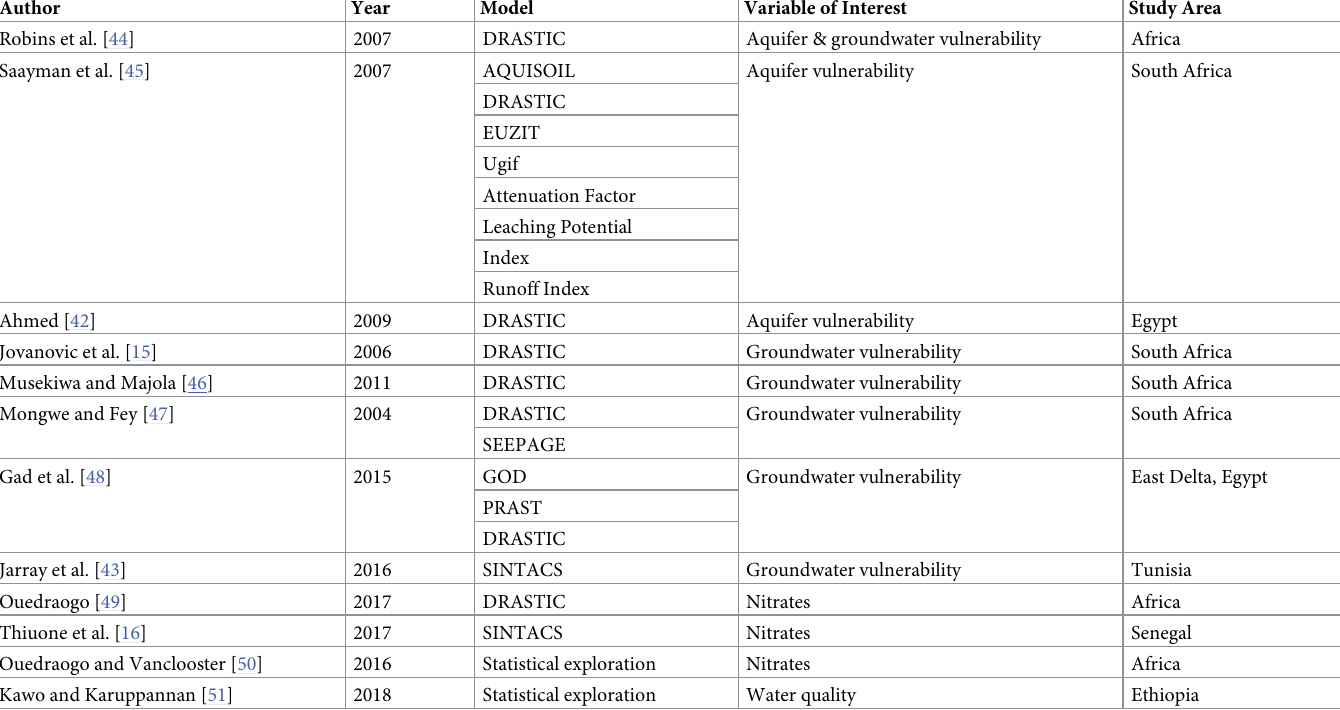
Table 4. Overview of conducted spatial and water vulnerability studies in Africa.